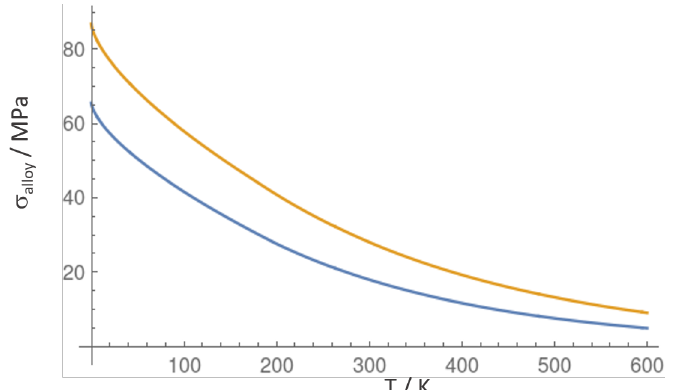
Figure 9. Yield stress versus temperature for c Cr = 16 at.% (orange, strongest alloy) and c Mn = 12 at.% (blue, softest